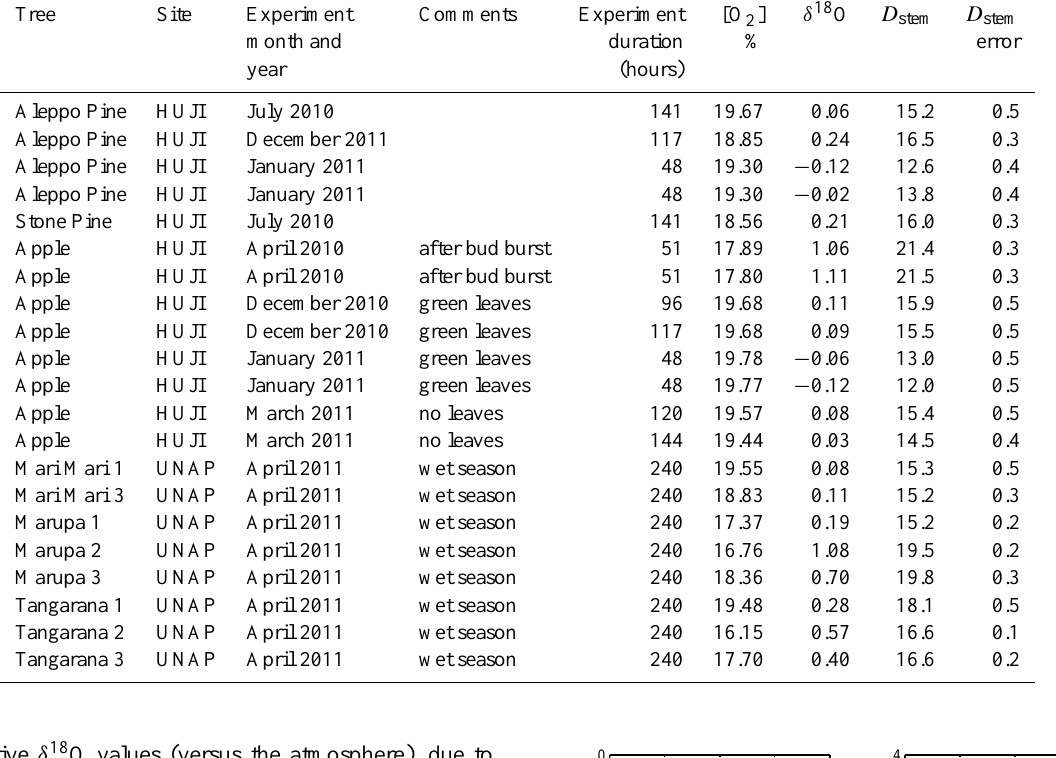
Table 1. Summary of the stem chamber experiments. The D stem error is calculated from the analytical uncertainty. Tree Site Experiment